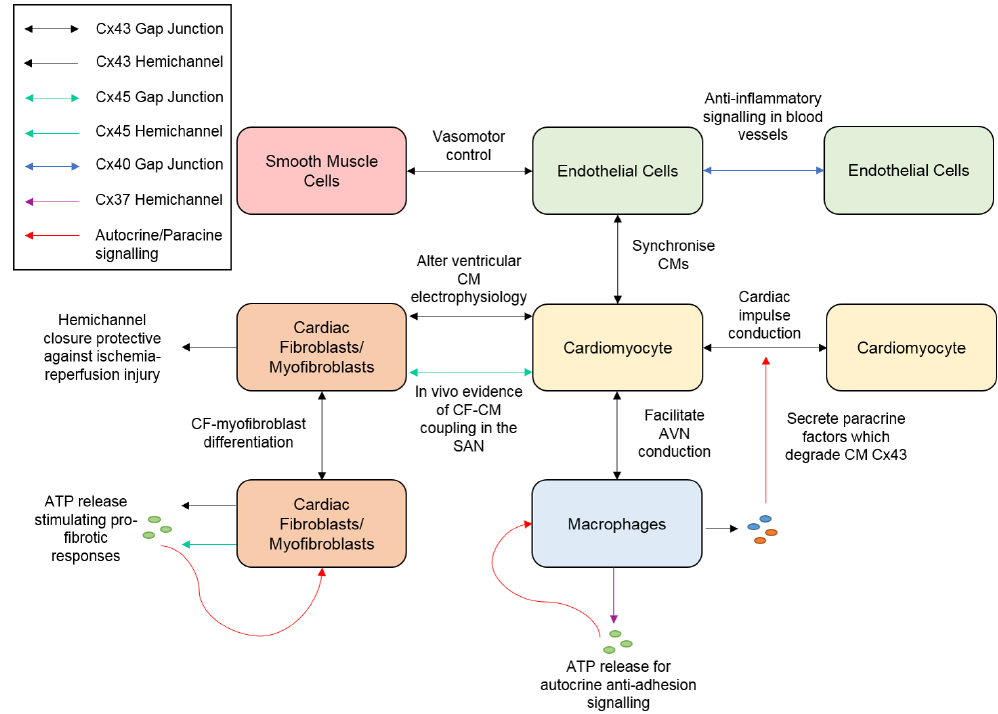
Figure 4. Schematic summary of connexin-based signalling in cardiac non-myocyte populations. Abbreviations: CM = Cardiomyocyte. CF = Cardiac Fibroblast. Cx = Connexin. SAN = Sinoatrial node. AVN = Atrioventricular node. ATP = Adenosine